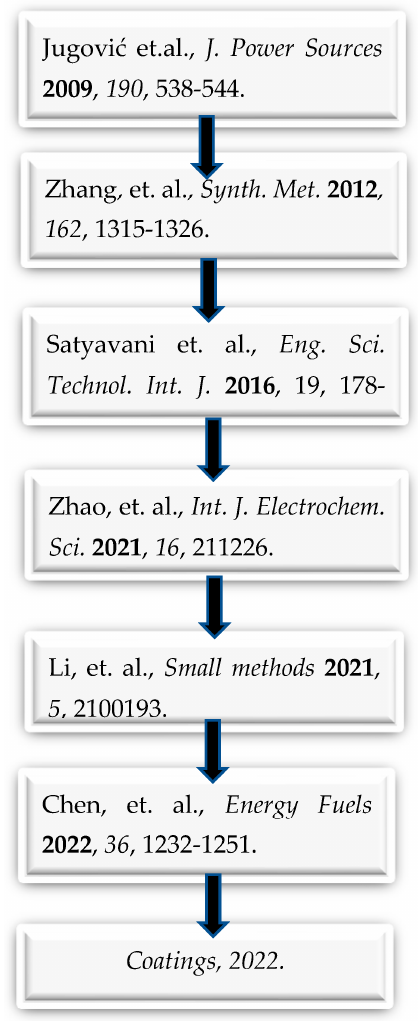
Figure 3. Time frames of review papers on the synthesis of LiFePO 4 [49–54].